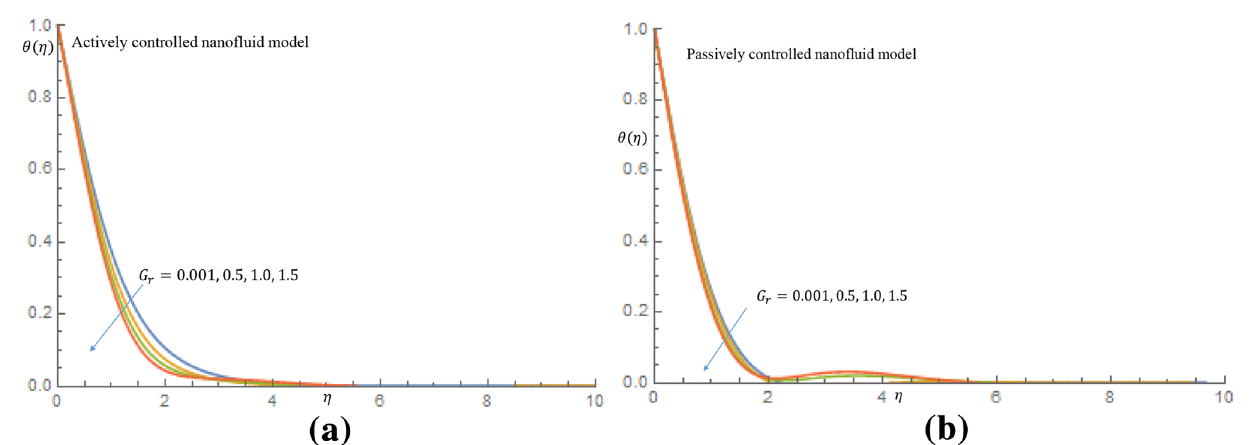
Figure 5. ( a ) Effect of G r on temperature profile when N r = N b = 0.75 . ( b ) Effect of G r on temperature profile when N r = N b = 0.75 .